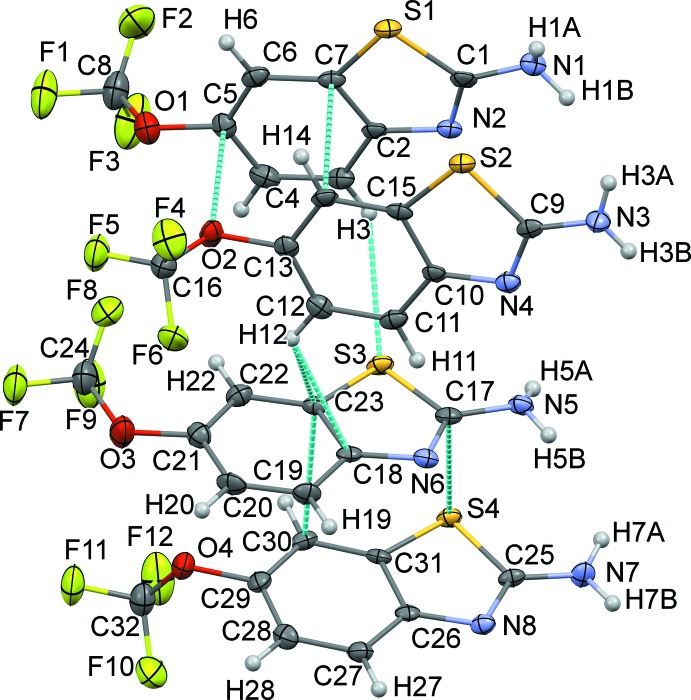

ORTEP view of riluzole drawn with 50% ellipsoidal probability. The dotted lines depict inter­molecular inter­actions in the asymmetric unit.